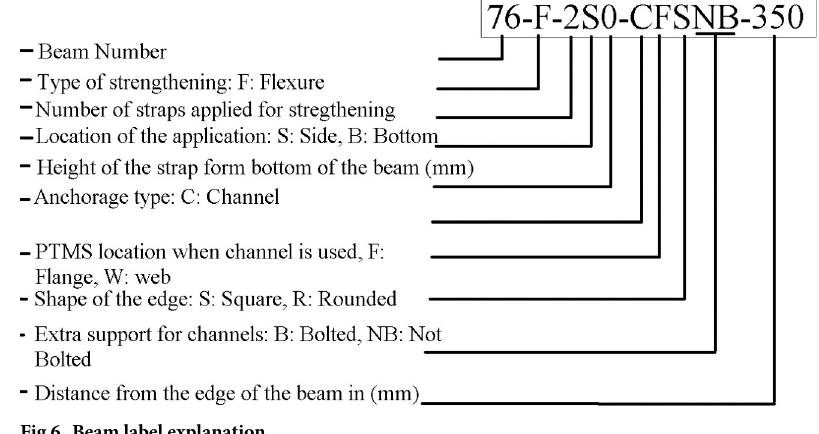
Fig 6. Beam label